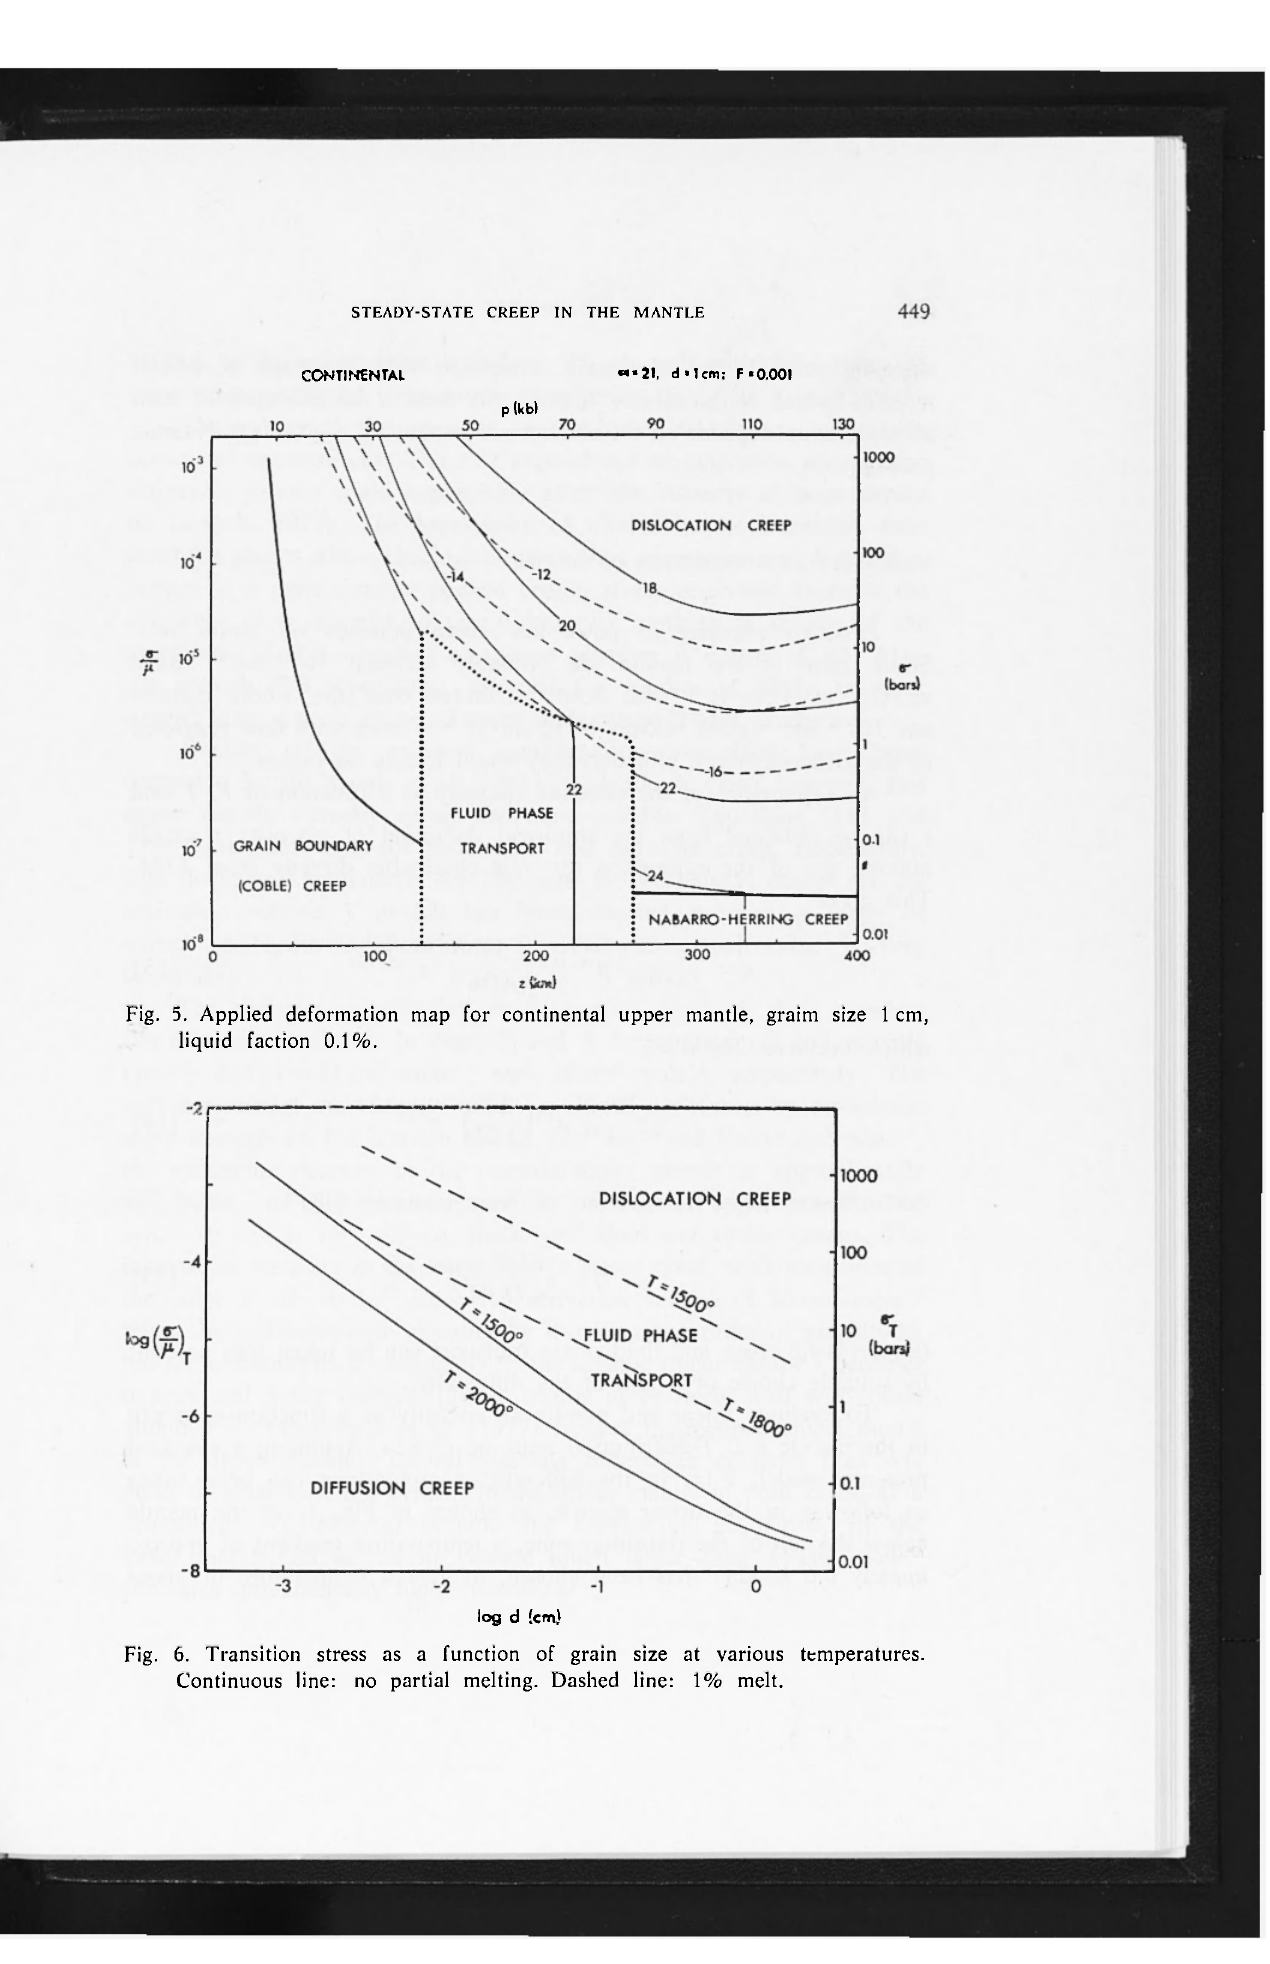
Fig. 6. Transition stress as a function of grain size at various temperatures. Continuous line: no partial melting. Dashed line: 1%